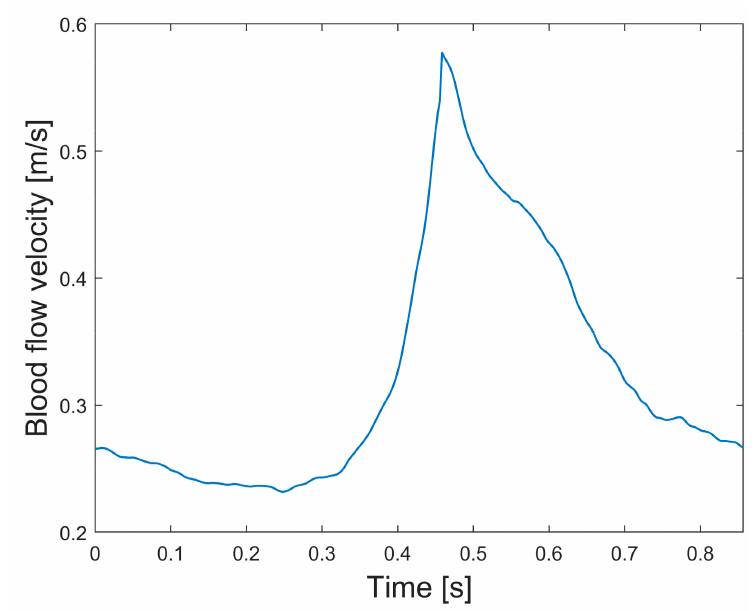
Figure 3. Averaged blood flow pulse used as the inlet boundary condition.